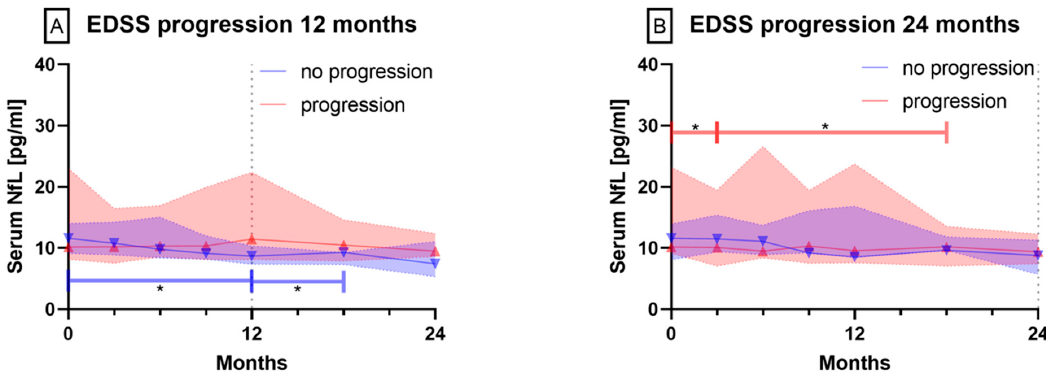
Figure 3. Serum NfL levels over 12 and 24 months in patients with (red triangle up) and without EDSS progression (blue triangle down) within ( A ) 12 or ( B ) 24 months. Symbols show median values, colored range indicates 95% CI, * p < 0.05 .